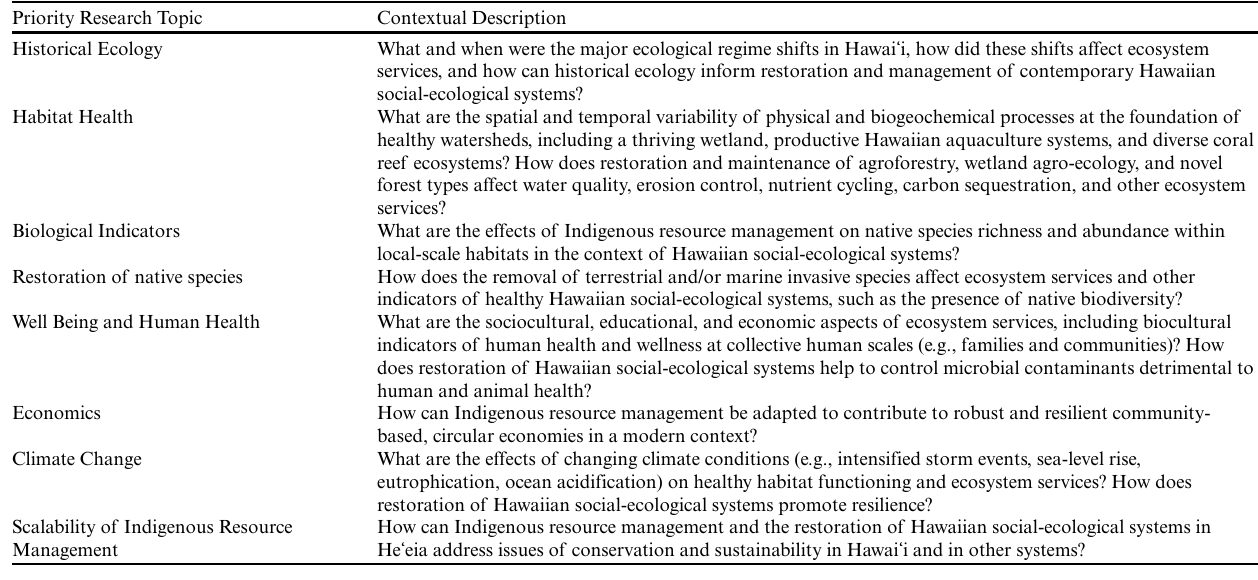
Table 2 . The priority research topics identified for the inaugural phase of the He ʻ eia National Estuarine Research Reserve via participatory processes that included researchers, collaborative management partners, and IPLC members. Contextual descriptions for each priority research topic is